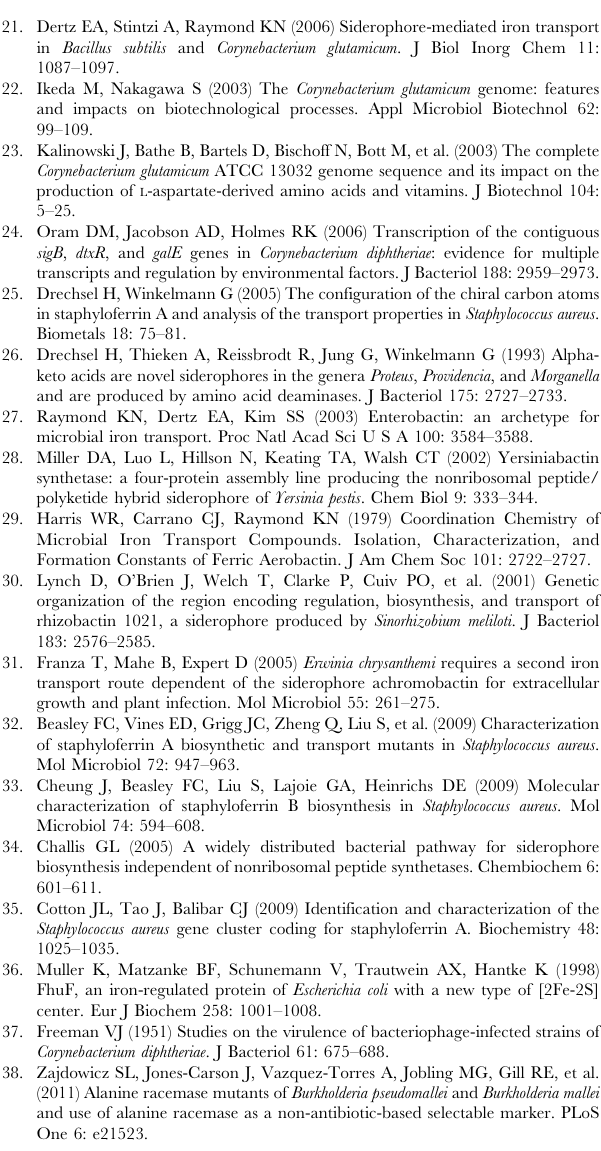
Figure S1 Initial purification of corynebactin by anionic exchange chromatography on Source 15Q resin.